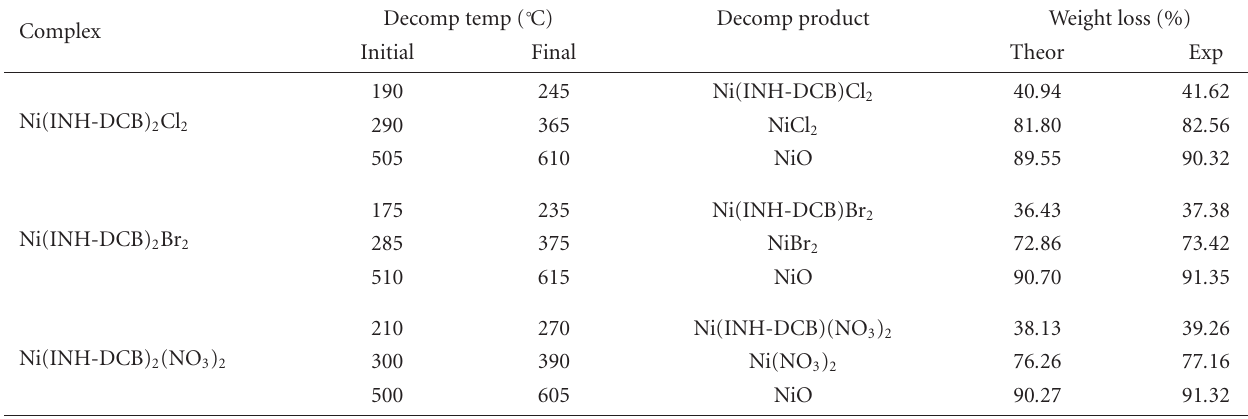
Table 6: Thermoanalytical results obtained for Ni 2+ of INH-DCB.